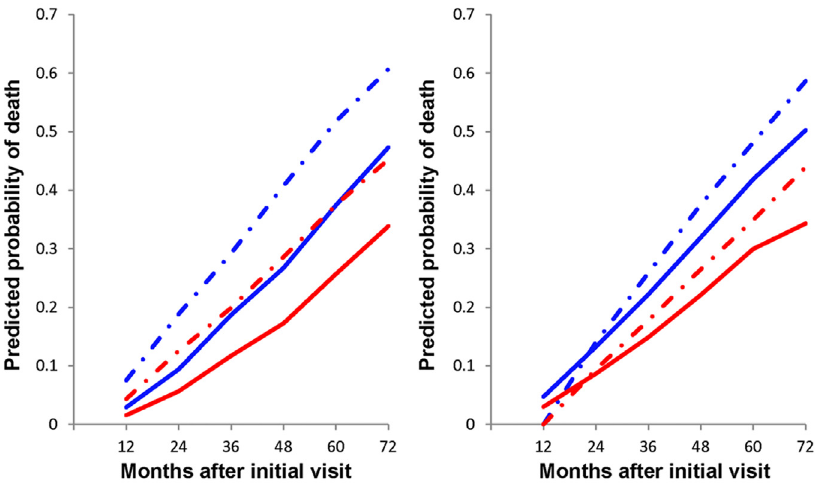
Fig 2. Predicted conditional probability of death for patients with and without cognitive based basic ADL impairment. (A)In the left panel, impairment was defined by PSMS (cid:1) 7. (B)In the right panel, impairment was defined by PSMS (cid:1) 2 points of increase relative to baseline. The predicted conditional probability of death over the first 6 years was calculated for each sex (men in blue and women in red) assuming either intact (the solid lines) or impaired (the dashed lines) basic ADL at time of